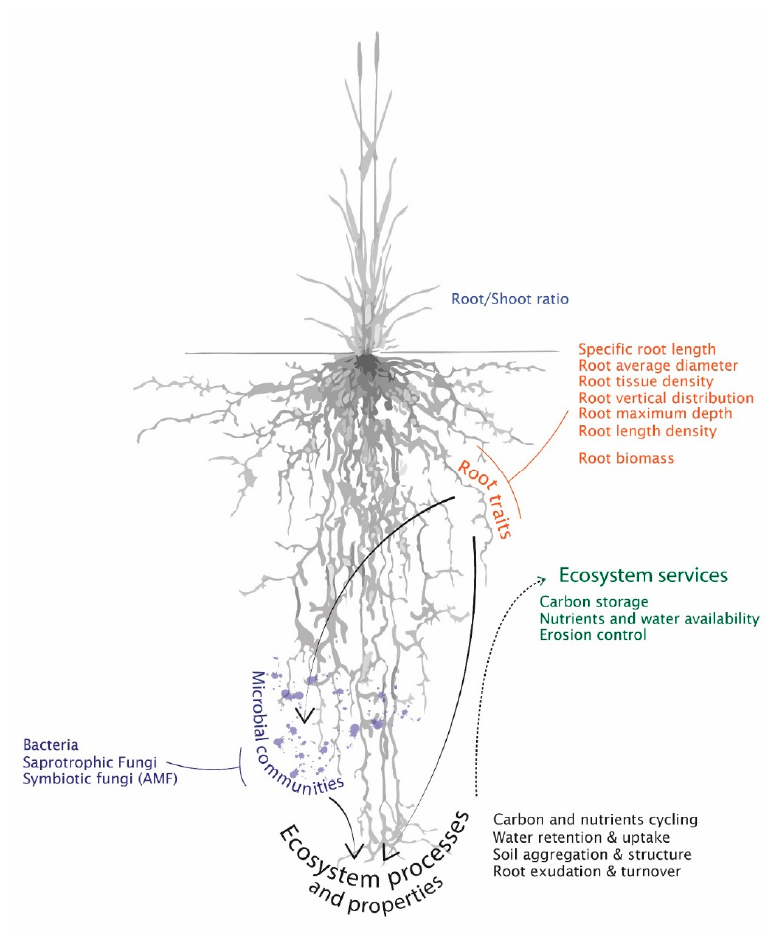
Figure 1. Influence of root traits and microbial indicators on soil ecosystem processes.